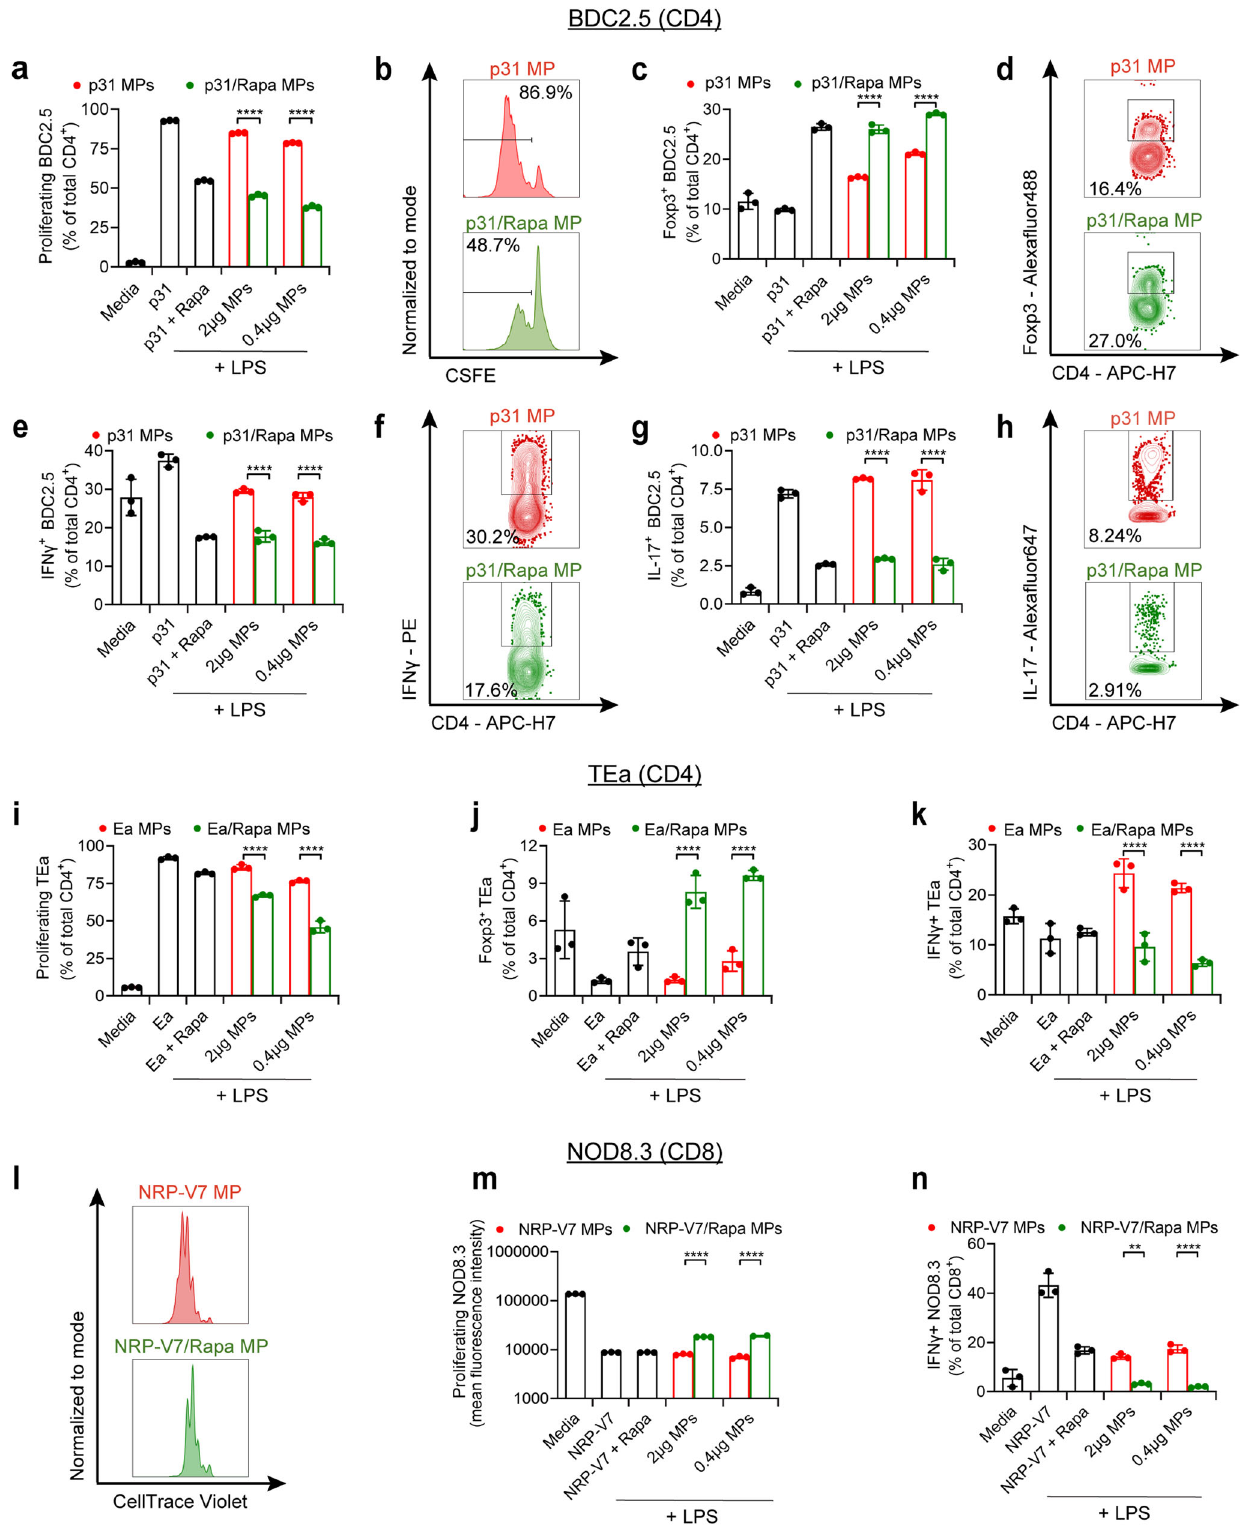
Fig. 2 | MPs encapsulating relevant antigens and Rapa promote suppressive T cell responsesin vitro. BDC2.5T cellco-culturesweretreated with p31MP or p31/ RapaMPs. a Quanti fi cationofBDC2.5 Tcellproliferationand b representative fl ow cytometry plots of CSFE dilution are shown. c Quanti fi cation of Foxp3 expression and d representative fl ow cytometry plots are shown. e Quanti fi cation of IFN γ expressionand f representative fl owcytometryplotsareshown. g Quanti fi cationof IL-17expressionand h representative fl owcytometryplotsareshown.TEaTcellco- cultures were treated with Ea MP or Ea/Rapa MPs. Quanti fi cation of i proliferation,